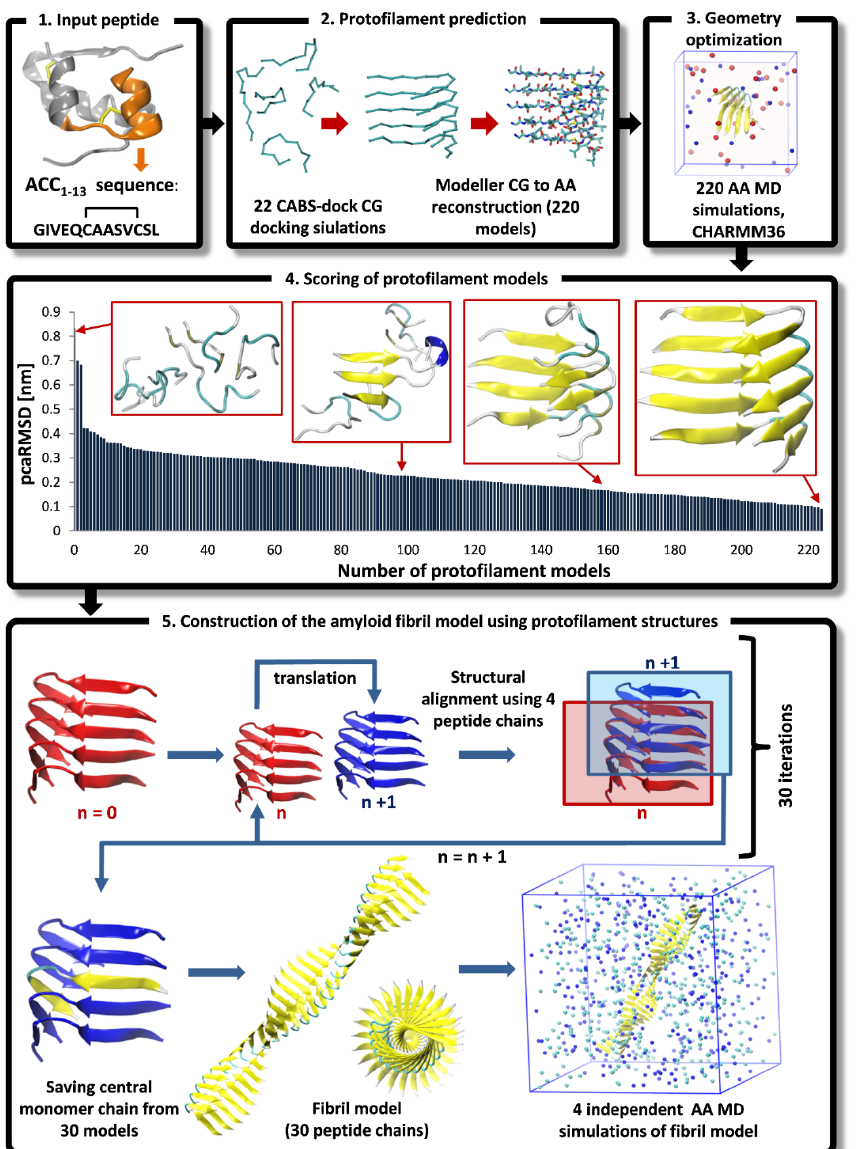
Figure 1. The multiscale modeling procedure for prediction of amyloid fibril structures: (1) preparation of input data for the peptide molecule; (2) prediction of the protofilament structures using CG CABS-dock simulations followed by AA reconstruction; (3) geometry optimization ; (4) scoring and selecting the best protofilament models; (5) construction of an amyloid fibril model using the protofilament structures as the building blocks, followed by geometry optimization using AA MD simulations in explicit solvent. For a detailed description of the above procedure see Section 2.3.